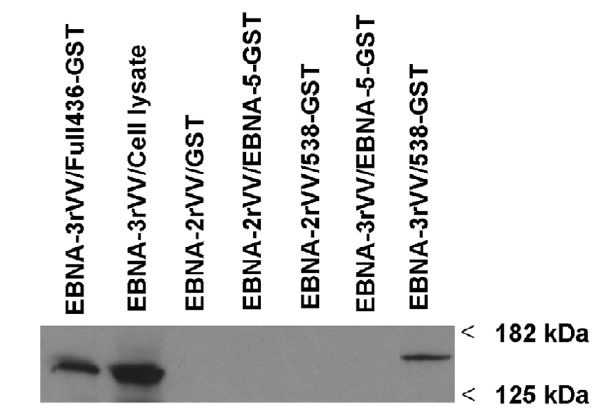
Figure 4 GST-538, but not different control fusion proteins precipi- tates EBNA-3 from CV-1 cell lysates infected with recom- binant vaccinia virus as detected by Western blotting.